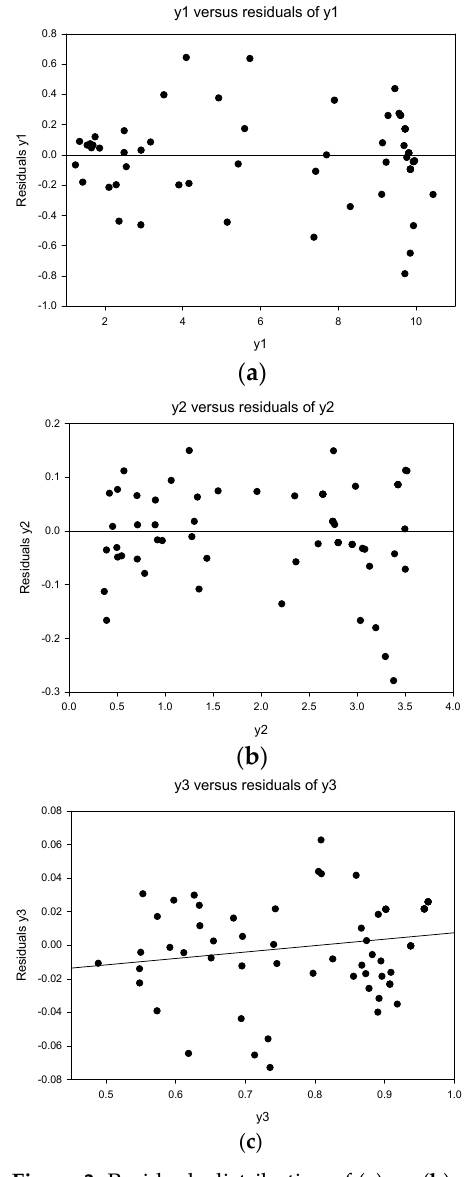
Figure 3. Residuals distribution of ( a ) y 1 ; ( b ) y 2 ; ( c ) predicted y 3 . Table 4. Response of EDAOpt As can be seen, 3 y residuals have little dependence on registered values—the re- gression line is not precisely horizontal. But this dependence is small and tolerable. As Appendix Figure A1 shows, the histograms of the residuals are nearly similar to the normal distribution. The normal probability plot was also tested in Figure A2. Graph points are not far from the straight line.